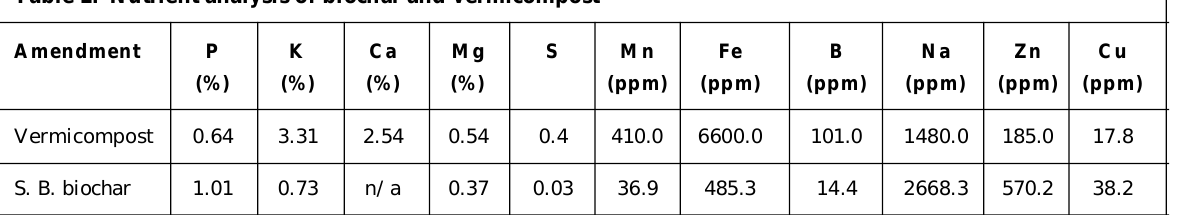
Table 2: Nutrient analysis of biochar and vermicompost Amendment